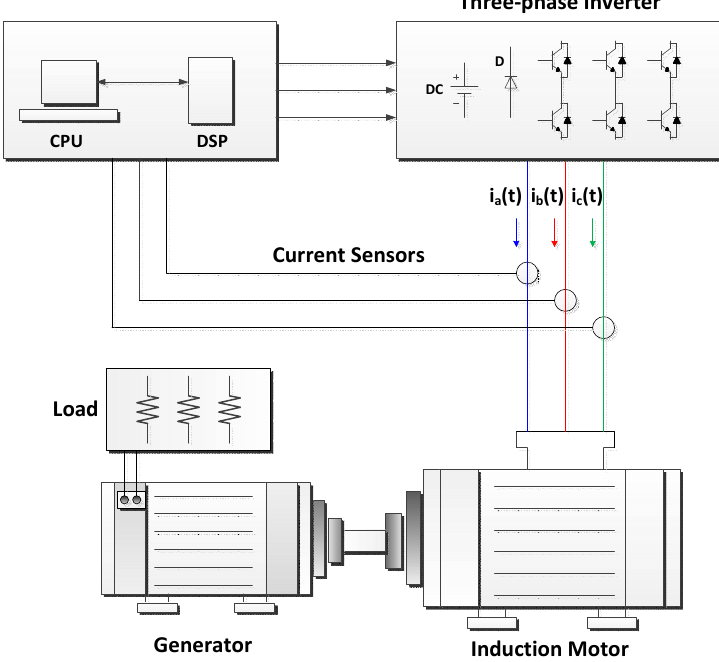
Figure 5. Test bench scheme for experimentation.